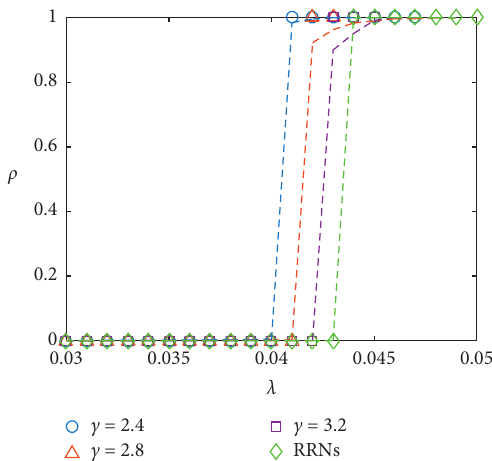
Figure 6: The prevalence ρ in the stationary as a function of λ on scale-free networks with degree exponent c � 2 . 4 (blue circles), c � 2 . 8, and c � 3 . 2 (purple squares). And, the result on random regular networks (RRNs) marked by the red rhombus. Symbols represent the results obtained from Monte Carlo simulations, and lines represent results of the GDMP method. The parameter α is fixed at α � 0 .